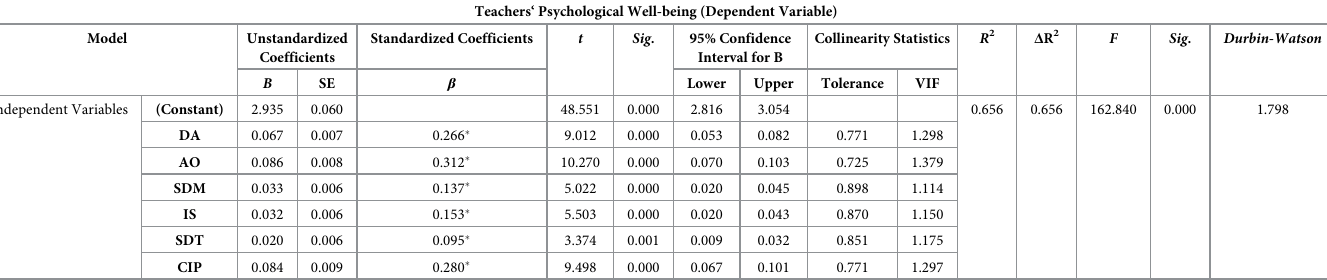
Teachers‘PsychologicalWell-being(DependentVariable)